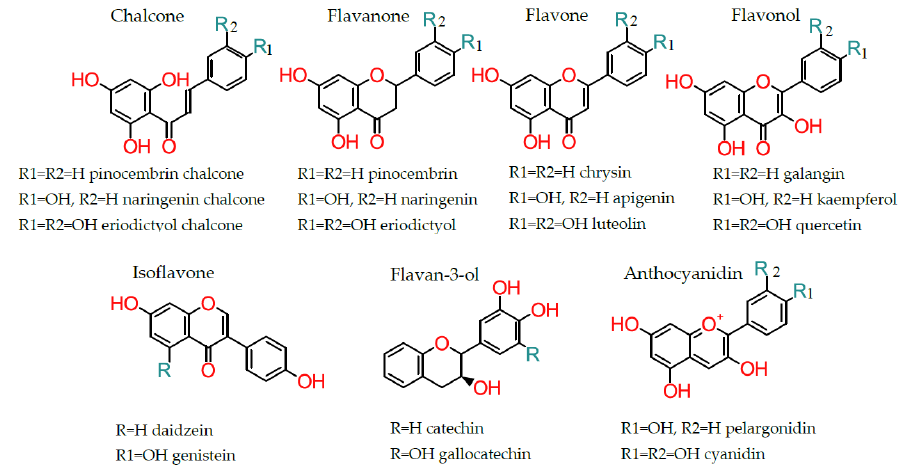
Figure 2. Flavonoid subclasses.